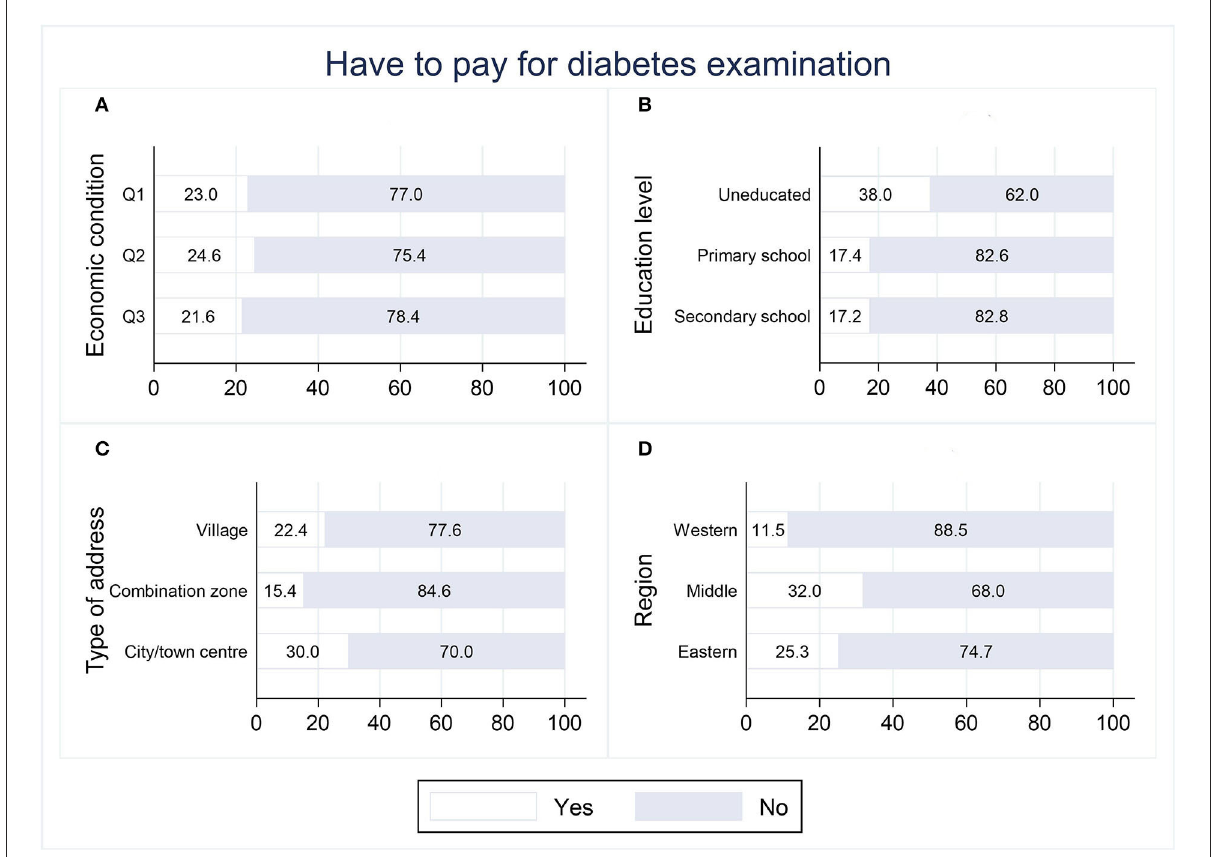
FIGURE3 Distribution of whether have to pay for community-based diabetes